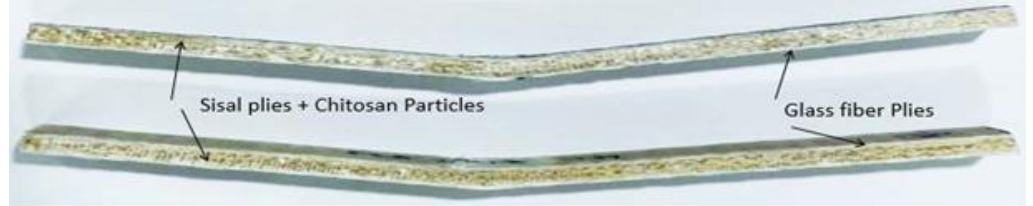
Figure 6. GF/SF/CTS hybrid sandwich composite scaffolds in a three-point bending. Figure 6. GF / SF / CTS hybrid sandwich composite sca ff olds in a three-point bending.